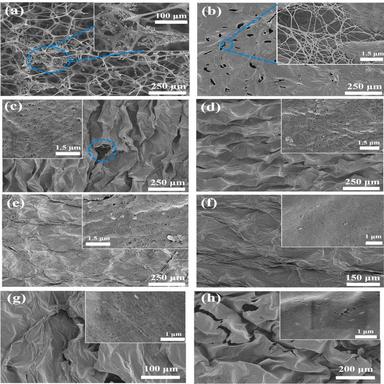
Representative SEM images from the surface views for (a) BC16-MF; (b) BC32-MF; (c) BC48-MF; (d) BC64-MF; (e) BC96-MF; (f) C400BC64-MF; (g) C600BC64-MF; (h) C800BC64-MF.